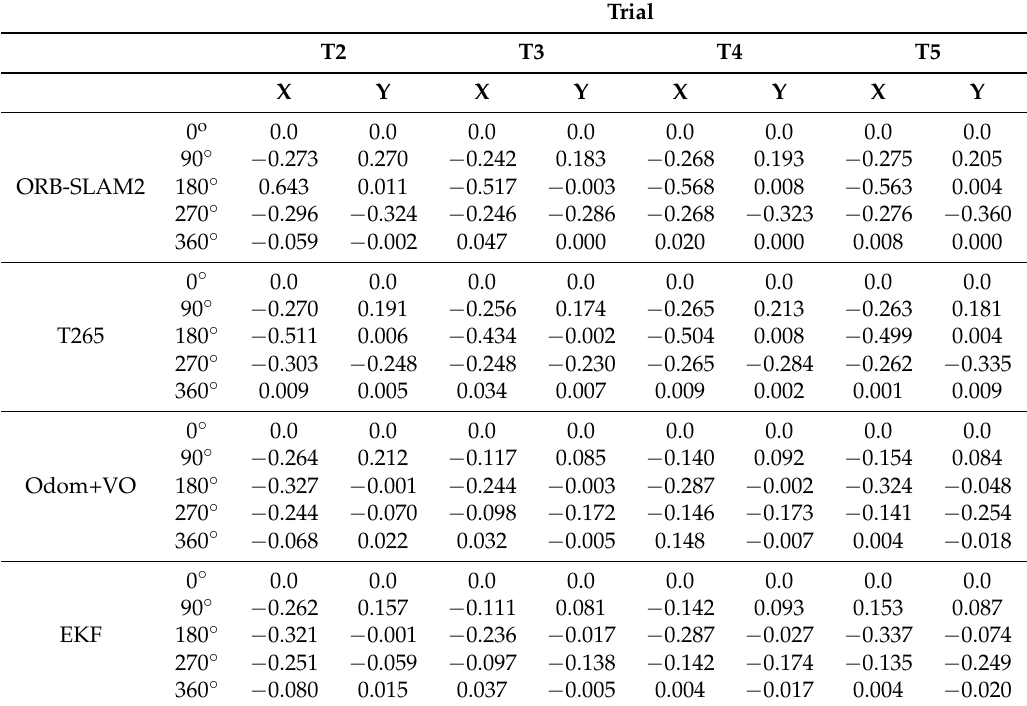
Table 11. Translational error for turn in place test. Angle units—degrees. Error units—m.